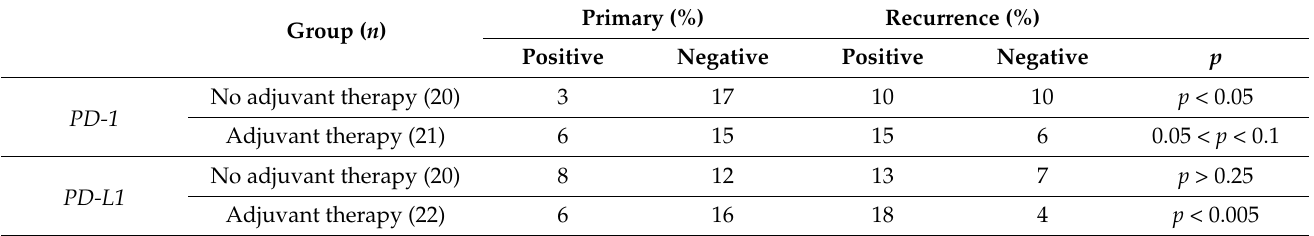
Table 2. Effect of postoperative adjuvant therapy on the expression of PD-1 and PD-L1 . Group ( n